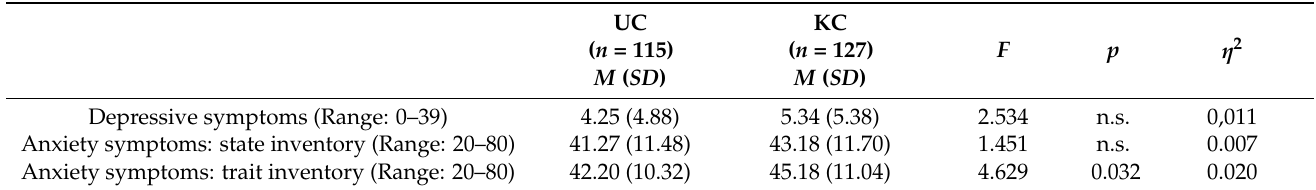
Table 3. Depressive and anxiety symptoms: comparison between victims of unknown and known perpetrators (one-way ANOVA).